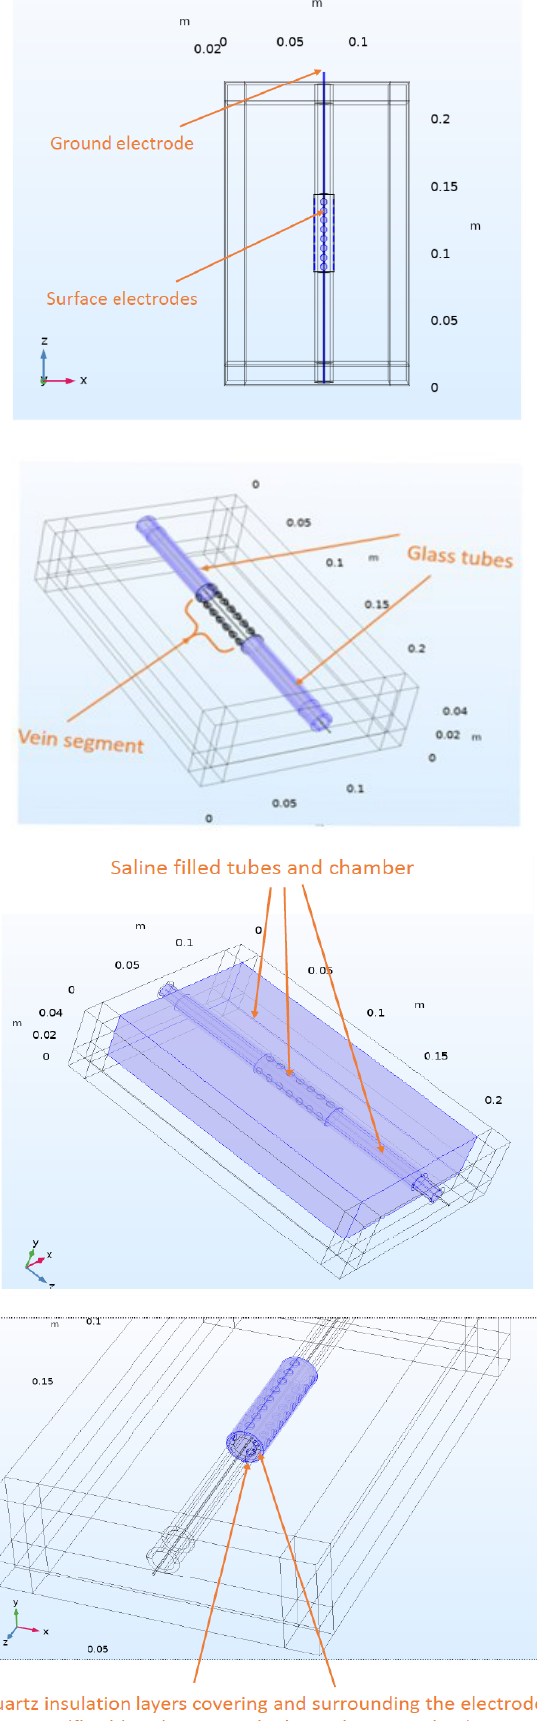
Figure 1: Different constituents of the COMSOL 3D finite element